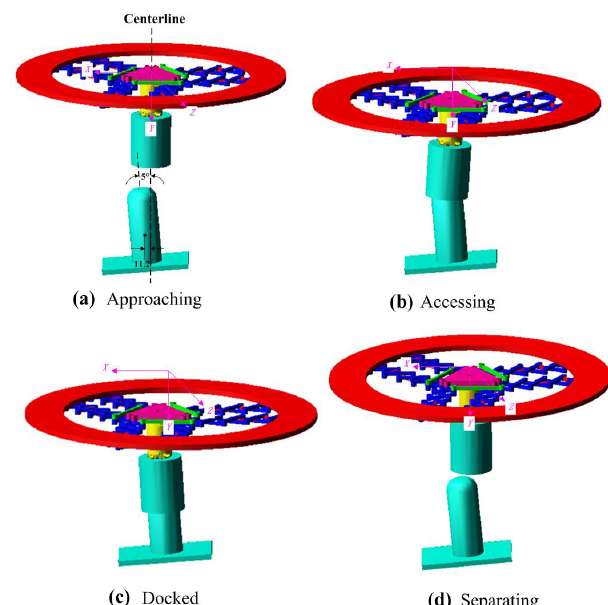
Figure 26. Docking procedure.